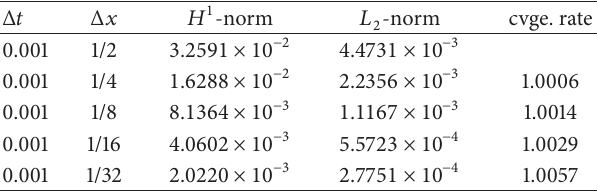
Table 2: Convergence rate in space for Example